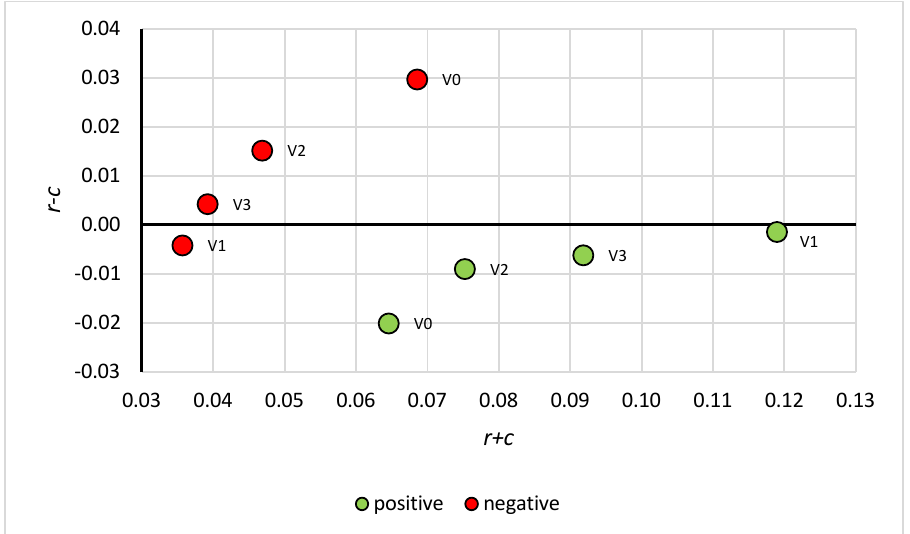
Figure 19. Influence map for variants.